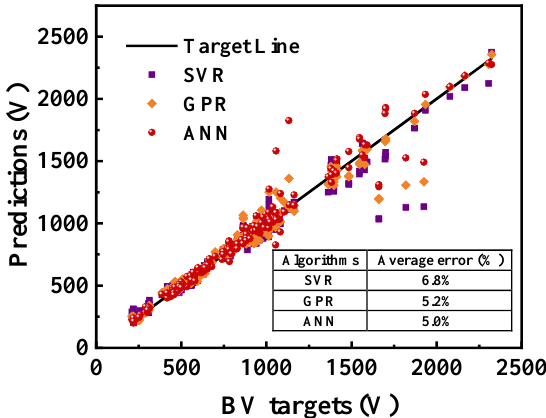
Figure 8. The breakdown voltage prediction results from the off-state I – V curve.